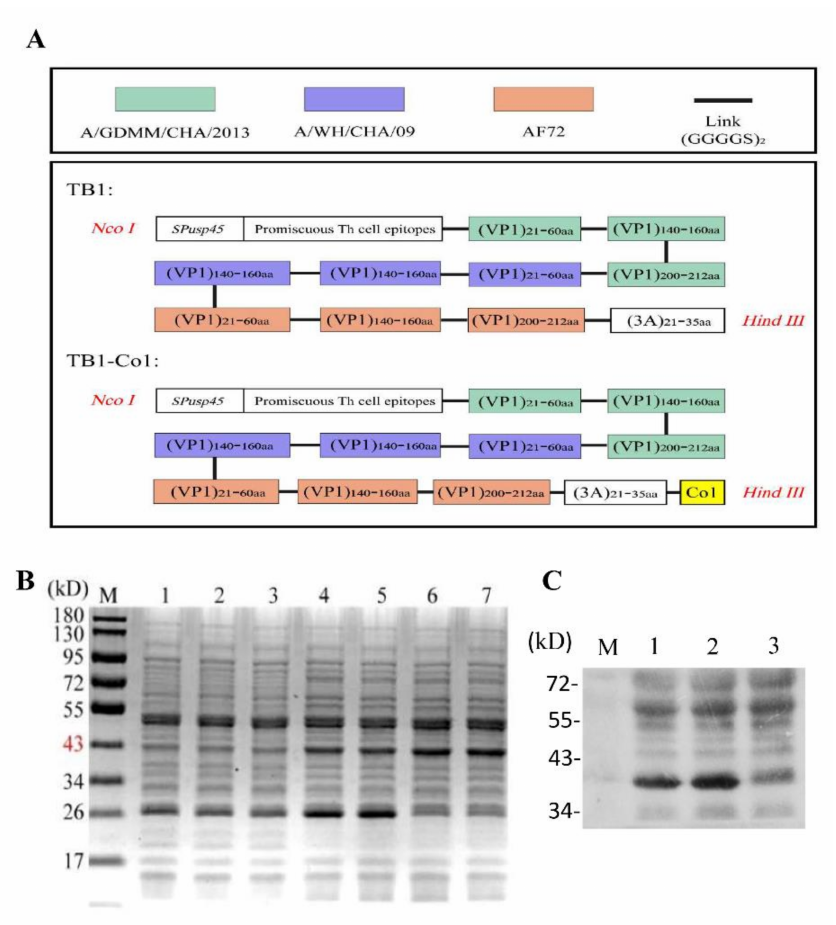
Figure 1. Design and evaluation of recombinant proteins in L. lactis NZ9000. ( A ) Schematic diagram of recombinant proteins design. ( B ) SDS–PAGE analysis of the two multi-epitope proteins. M: Protein marker; Lane 1: NZ9000/pNZ8148 with nisin as the control; Lane 2: L. lactis -TB1 without nisin; Lane 3: L. lactis -TB1-Co1 without nisin; Lane 4–5: L. lactis -TB1 with nisin; Lane 6–7: L. lactis -TB1-Co1 with nisin. ( C ) Western blot analysis of the fusion proteins. Lane 1: L. lactis -TB1 with nisin; Lane 2: L. lactis -TB1-Co1 with nisin; Lane 3: NZ9000/pNZ8148 with